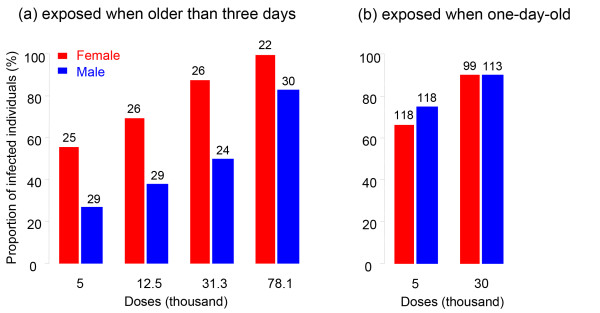
Proportion of infected male versus female D. magna hosts after exposure to P. ramosa spores. (a) The data correspond to Experiment 1, with long exposure time (for 11 days) of sexually dimorphic hosts (three-day-old). The proportion of infected increased with spore dose in both sexes (factor "Dose", df = 3, deviance = 34.9, P < 0.00001) and was always higher in females than in males (factor "Sex", df = 1, deviance = 27.4, P < 0.00001; interaction "Sex × Dose", df = 1, deviance = 1.35, P = 0.45). (b) The data correspond to Experiment 2, with short-exposure time (for two days) hosts to young to show sexual dimorphism (one-day-old). The infection rate increased with spore dose in both sexes (factor "Dose", df = 1, deviance = 26.5, P < 0.00001; interaction "Sex × Dose", df = 1, deviance = 1.33, P = 0.24). We did not observe a difference in the proportion of infected females versus males (factor "Sex", df = 1, deviance = 1.6, P = 0.21). We pooled the three host clones used in this experiment as they were not significantly different (factor "Host", df = 6, deviance = 8.1, P = 0.23). Numbers of replicates are given on top of each bar.